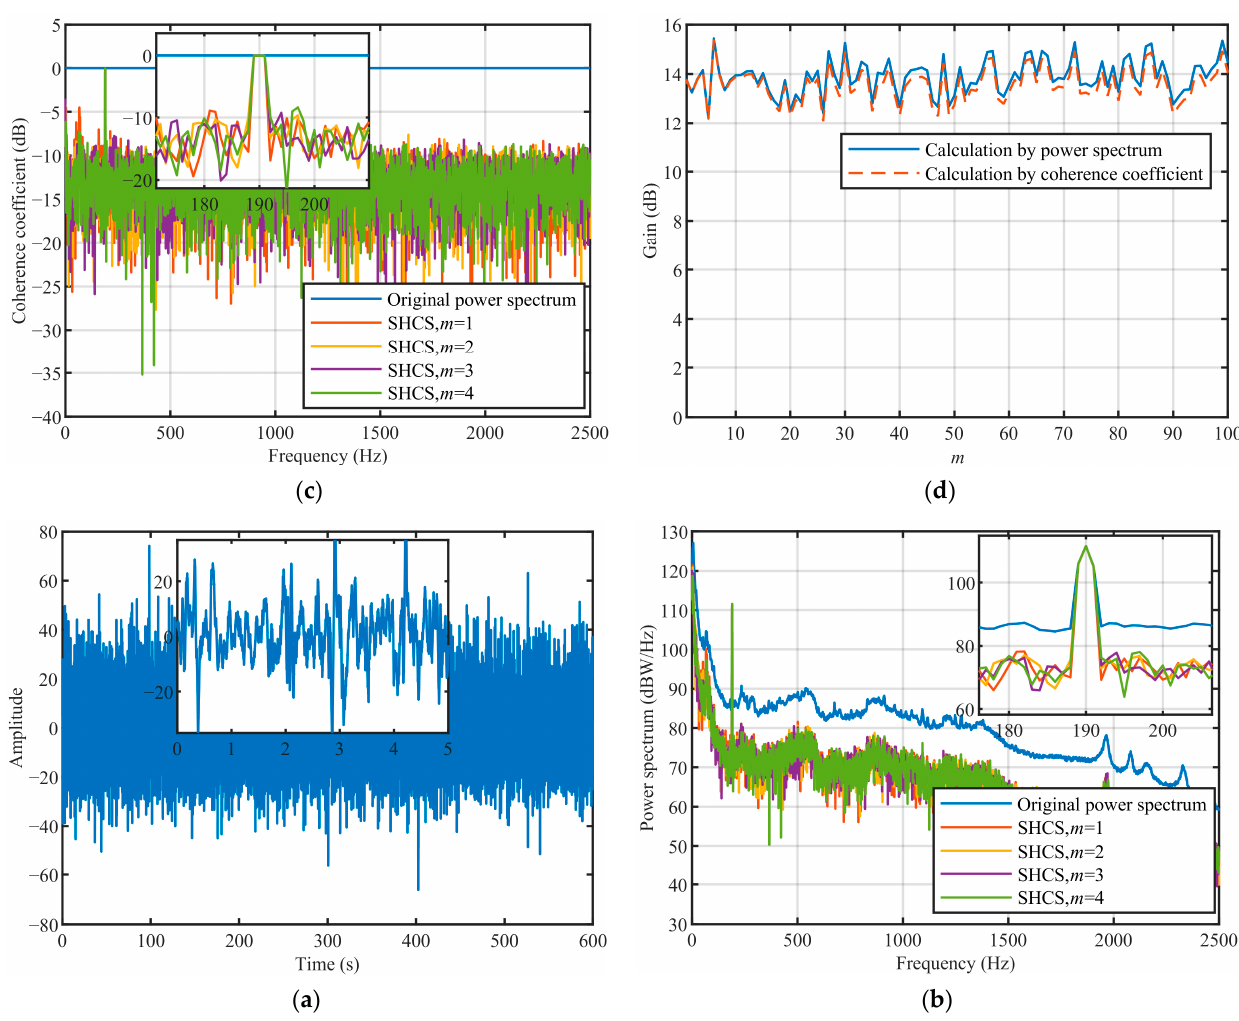
Figure 8. SHCS processing results at 10 km with different values of m : ( a ) time domain waveform; ( b ) power-spectrum estimation; ( c ) coherence coefficient; ( d )